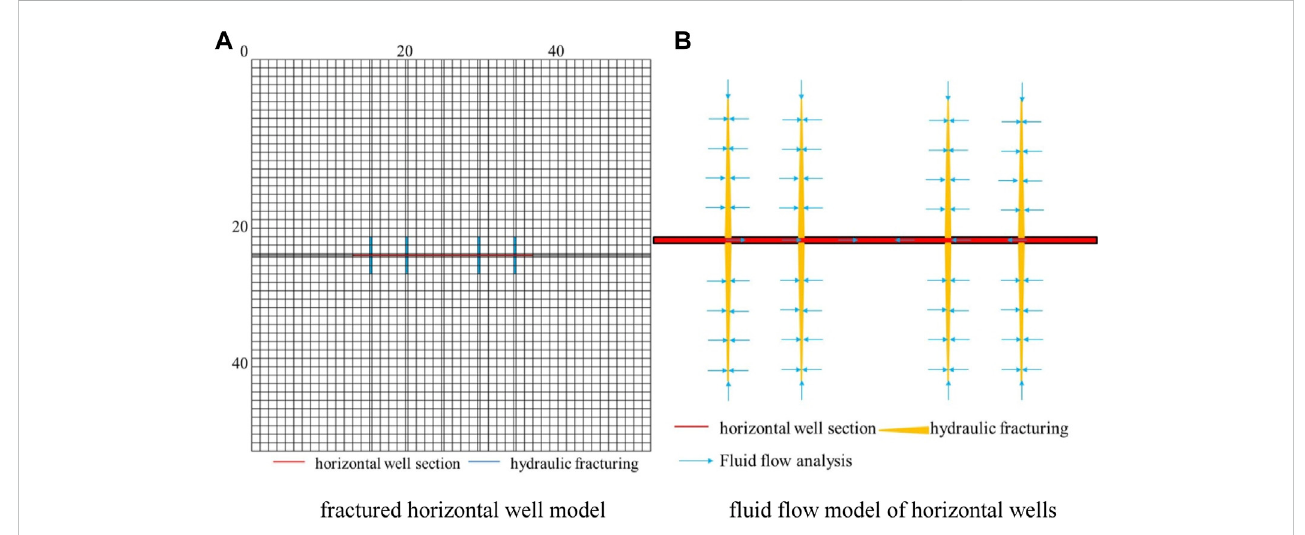
FIGURE 2 Fractured horizontal well model. (A) fractured horizontal well model, (B) fl uid fl ow model of horizontal wells.